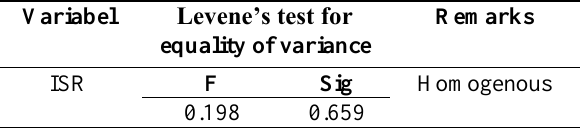
Source: Processed